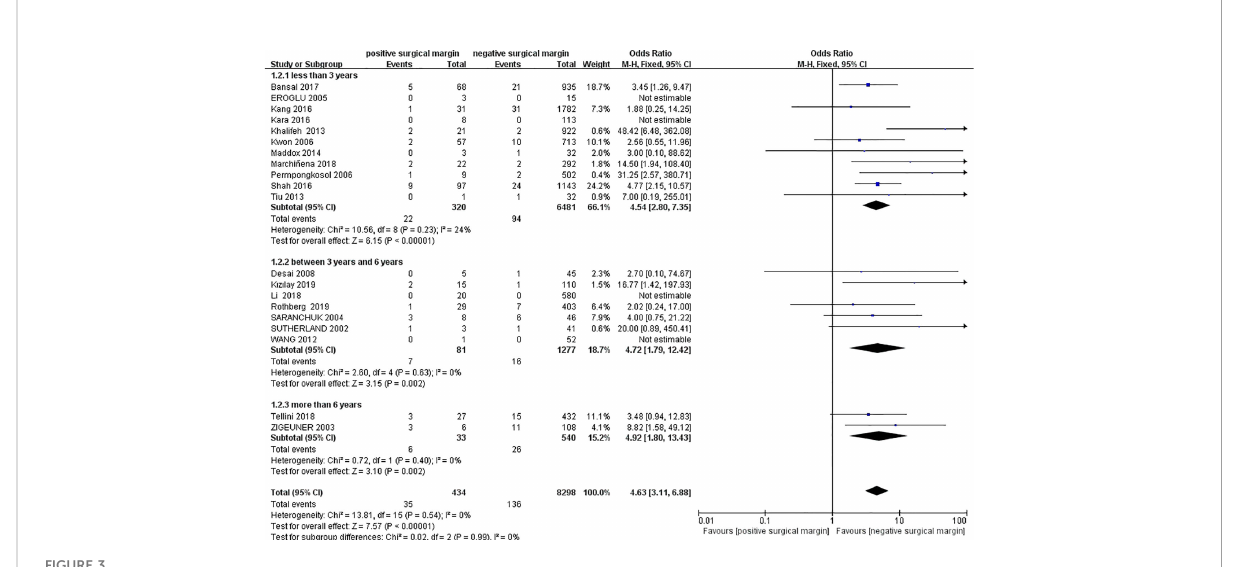
FIGURE 3 Comparison of metastasis between PSM and NSM groups.